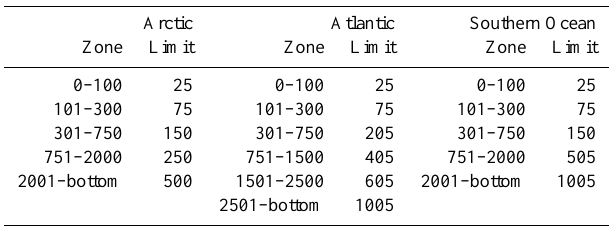
Table 4. Interpolation zones and limits. Zones and limits were determined by experimentation. For each interpolated value the ad- jacent measured values (above and below) can be separated by no more than the corresponding limit for the interpolated value to be deemed